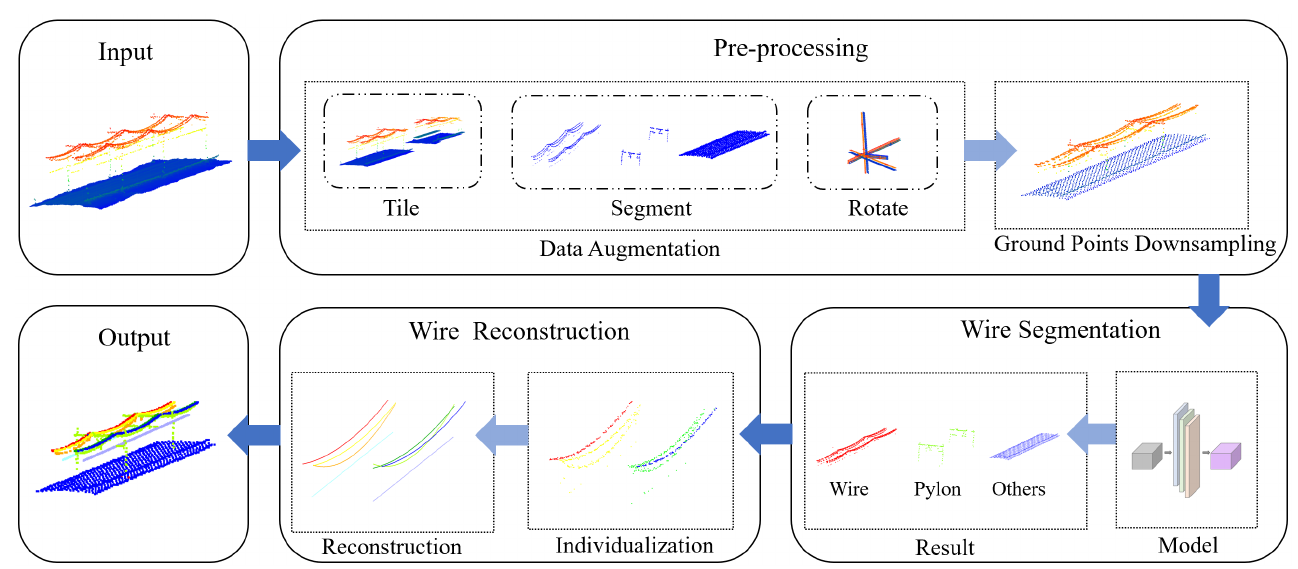
Figure 2. The overall procedure of the proposed method. First, raw data are preprocessed to obtain training data. Then, training data are fed into the proposed model for wire segmentation. Consecutively, the segmentation results are used for wire